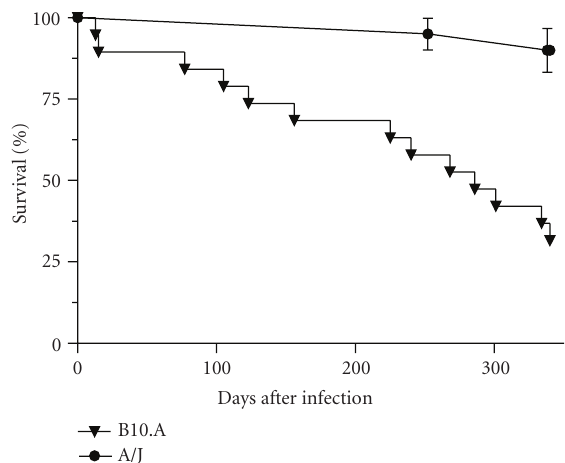
Figure 1: Cumulative survival rates during the infection period of A/J ( • ) and B10.A ( (cid:2) ) mice, each orally inoculated with 2000 viable eggs of Lagochilascaris minor . The survival ratio was determined using the Kaplan-Meier test ( P = .